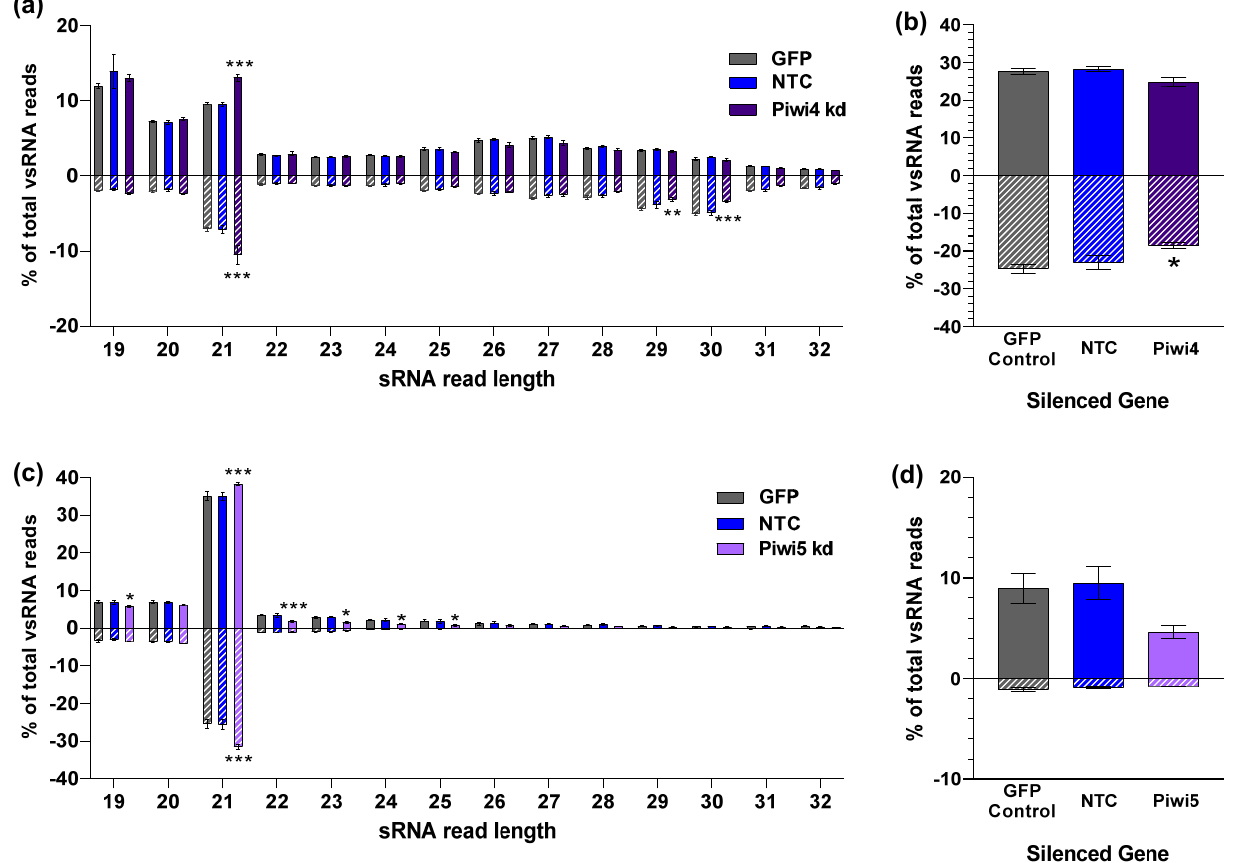
Figure 8. Arbovirus derived small RNAs in Cx. quinquefasciatus cells. sRNA libraries were sequenced from Hsu cells 2 dpi with ( a ) LACV MOI 10 or ( b ) USUV MOI 50. 19–32 nt reads were aligned to ( a ) LACV S segment, ( b ) USUV. Cells were treated with Piwi4 dsRNA ( a ), Piwi5 dsRNA ( b ), and GFP dsRNA or no dsRNA (NTC) as negative controls ( a , b ). Bars represent 3 biological replicates. Significant changes in reads compared to the GFP control are shown as* p < 0.05, ** p < 0.01, and *** p < 0.001.